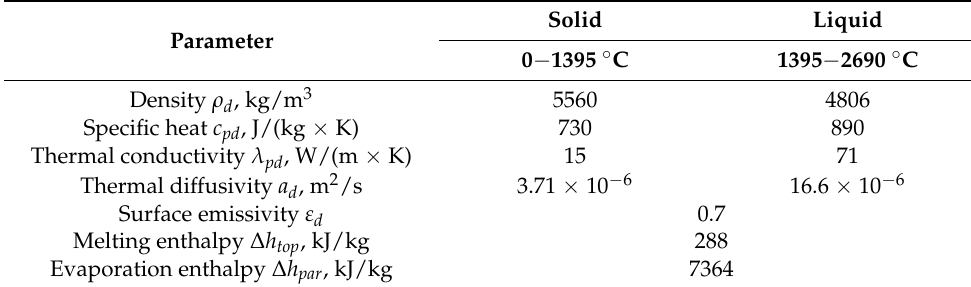
Table 5. Average results of the model calculated thermal-physical parameters for two characteristics temperature ranges corresponding to solid and liquid state of aggregation of the Fe40Al at.% powder material and the results of parameters of FeAl phase changes of melting and